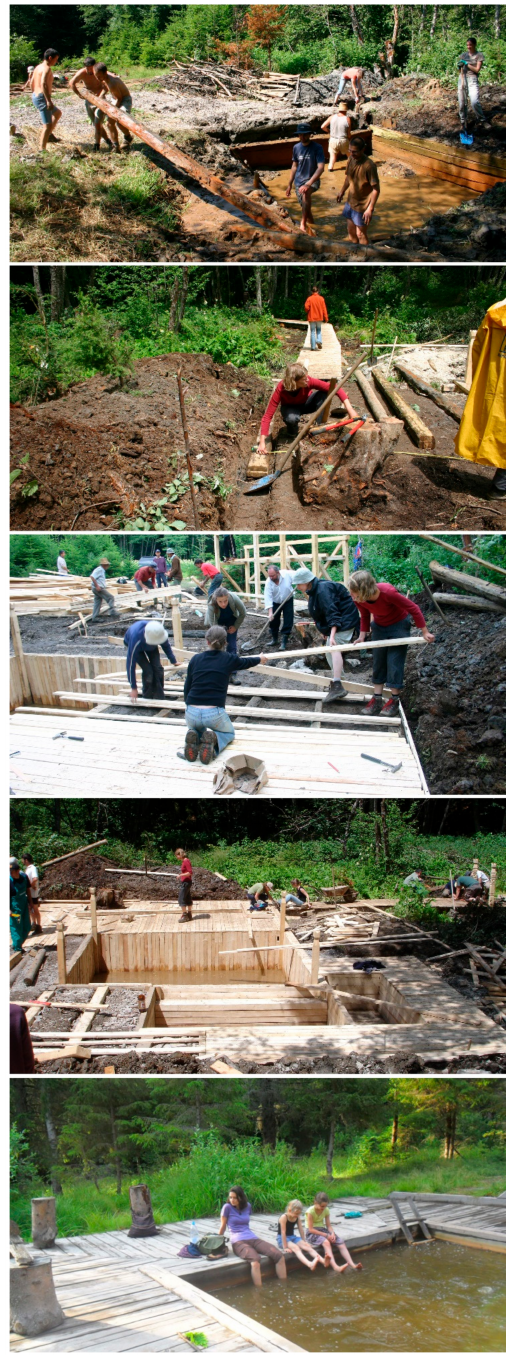
Figure 14. Design and build of a communal bath in a small village in collaboration with local craftsmen